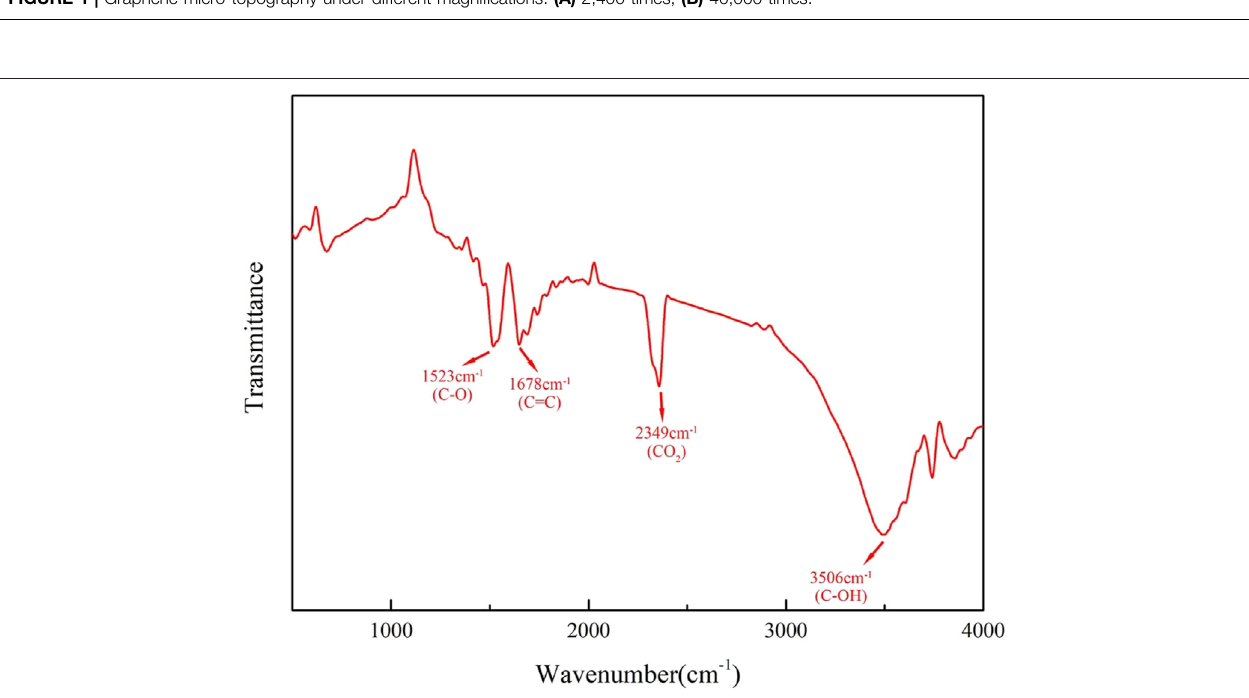
FIGURE 2 | Graphene FI-TR test